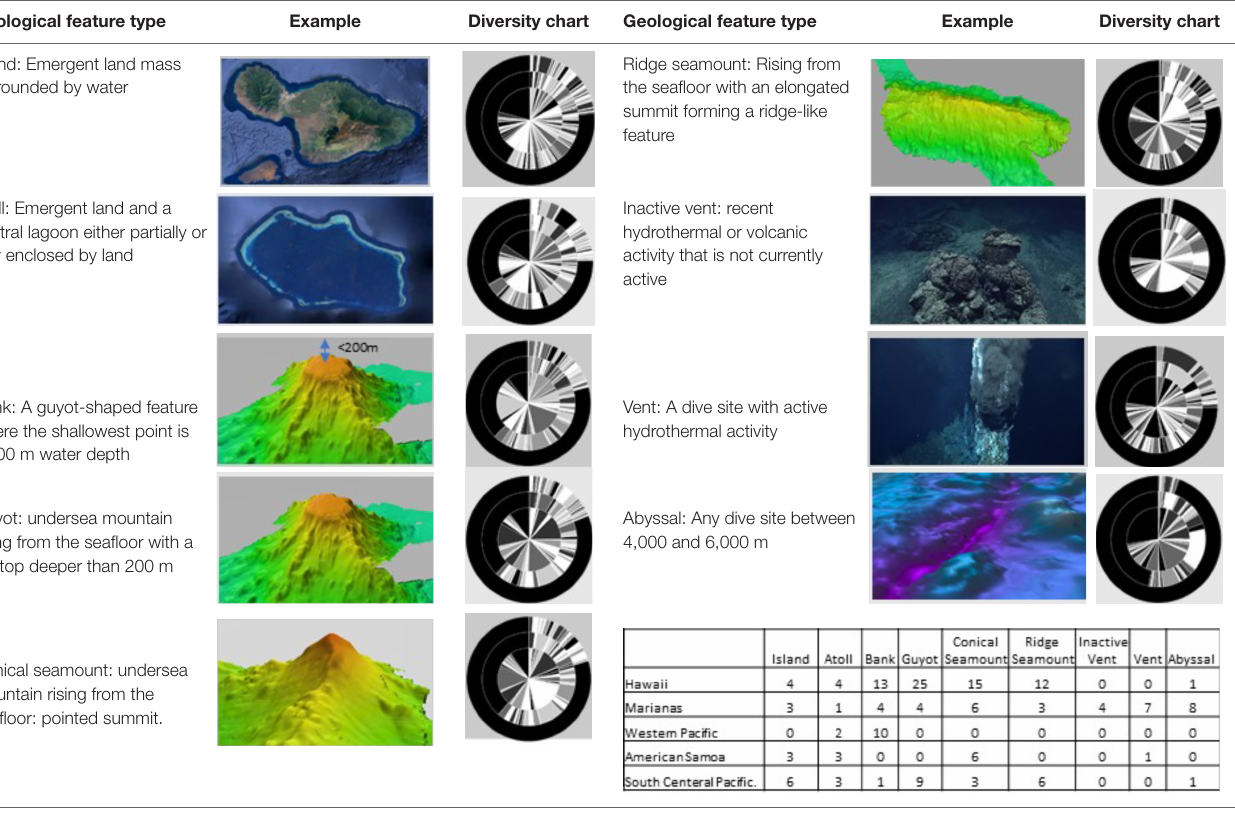
TABLE 1 | Definitions and diversity associated with the nine geological features measured by